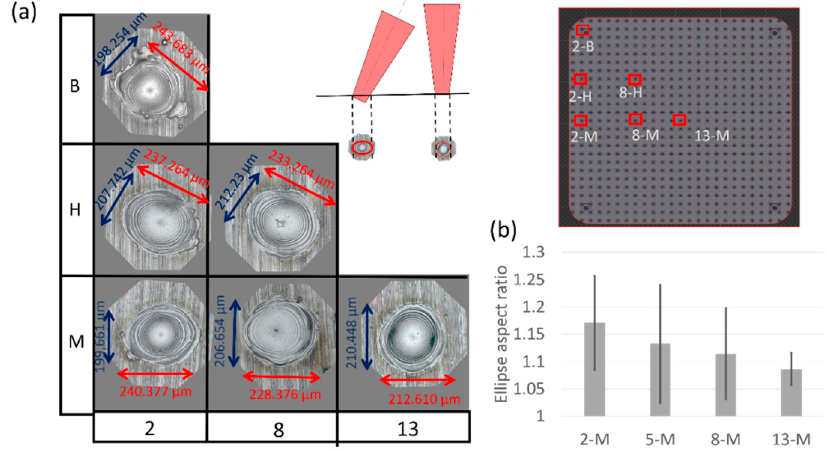
Figure 5. Analysis of the marks made by the laser on the platform: ( a ) diagram of some of the images obtained when at the central mark of the stars was analyzed (2-B, 2-H, 2-M, 8-M, 8-H, and 3-M); ( b ) ellipse aspect ratio of different stars analyzed.